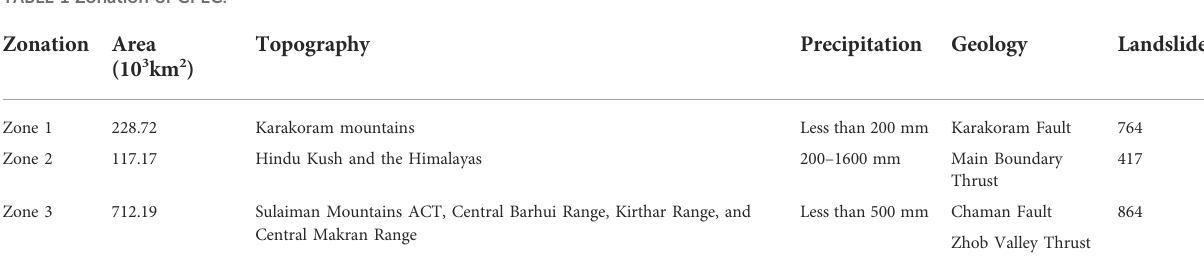
TABLE 1 Zonation of